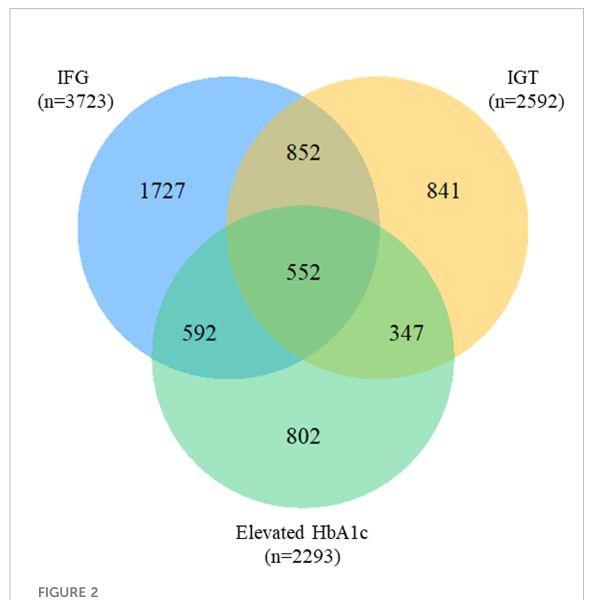
FIGURE 2 Venn diagram for the overlap of prediabetes criteria. IFG, impaired fasting glucose; IGT, impaired glucose tolerance; HbA1c, glycosylated